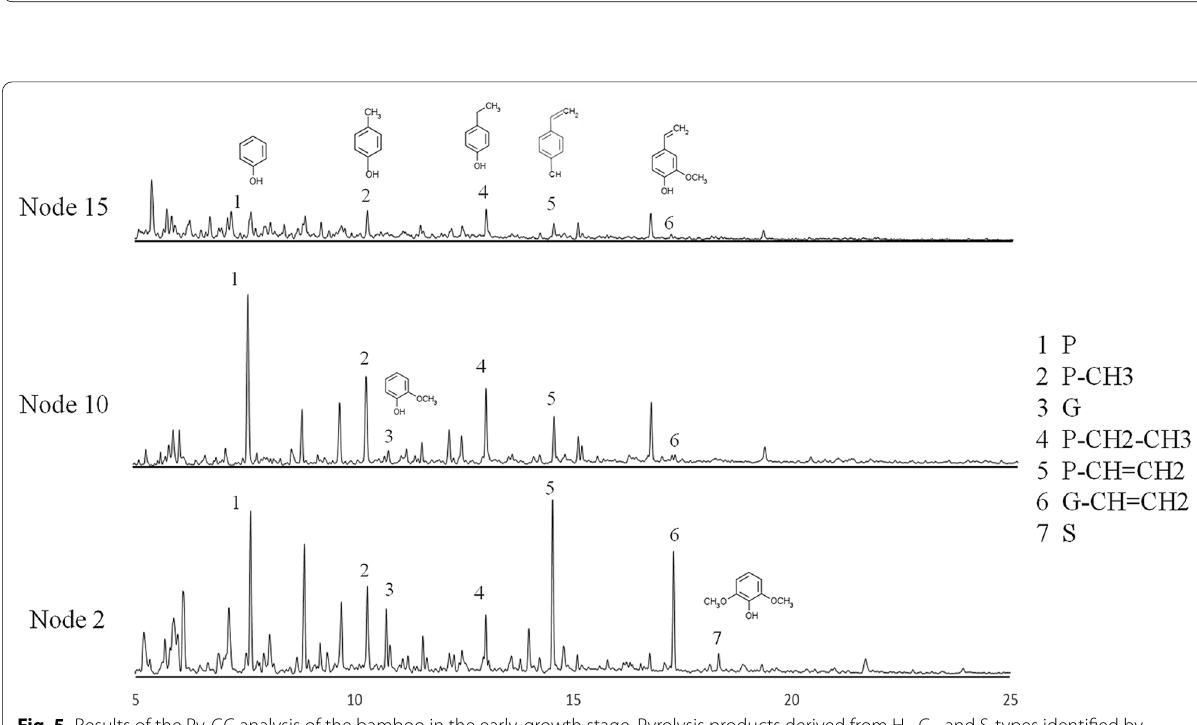
Fig. 4 H/G/S ratio of lignin in “Uradome” period. H/G/S ratios of pyrolysis products of lignin in the upper and lower parts of the "Uradome" of three samples. a sample 1: nodes 28, 31, 32, b sample 2: nodes 30, 33, 34, and c sample 3: nodes 30, 33, 34